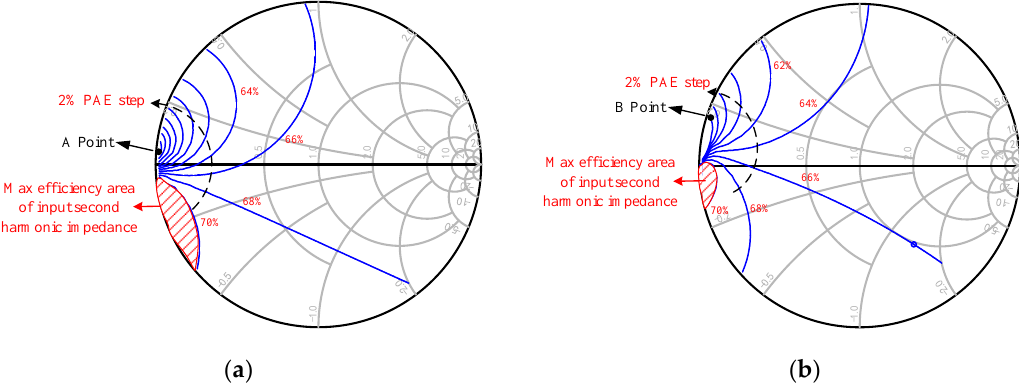
Figure 3. Input second-harmonic source-pull simulation results of 8 × 100 µ m FET with continuous class B mode at 10.5 GHz: ( a ) α = 0; ( b ) α = 1.